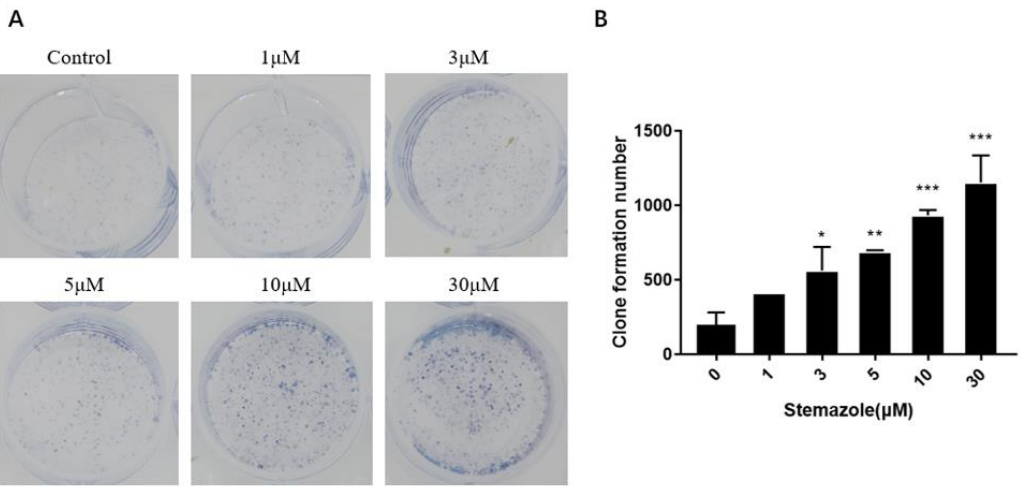
Figure 2. Stemazole promotes colony formation in OPCs. ( A ) Colony formation in OPCs as assessed by Giemsa staining. ( B ) Dose-dependent effects on the clone formation of monoclonal colonies. Data represent the means ± SD ( n = 3 duplicates), * p < 0.05, ** p < 0.01, *** p < 0.001. vs. 0 μM group.